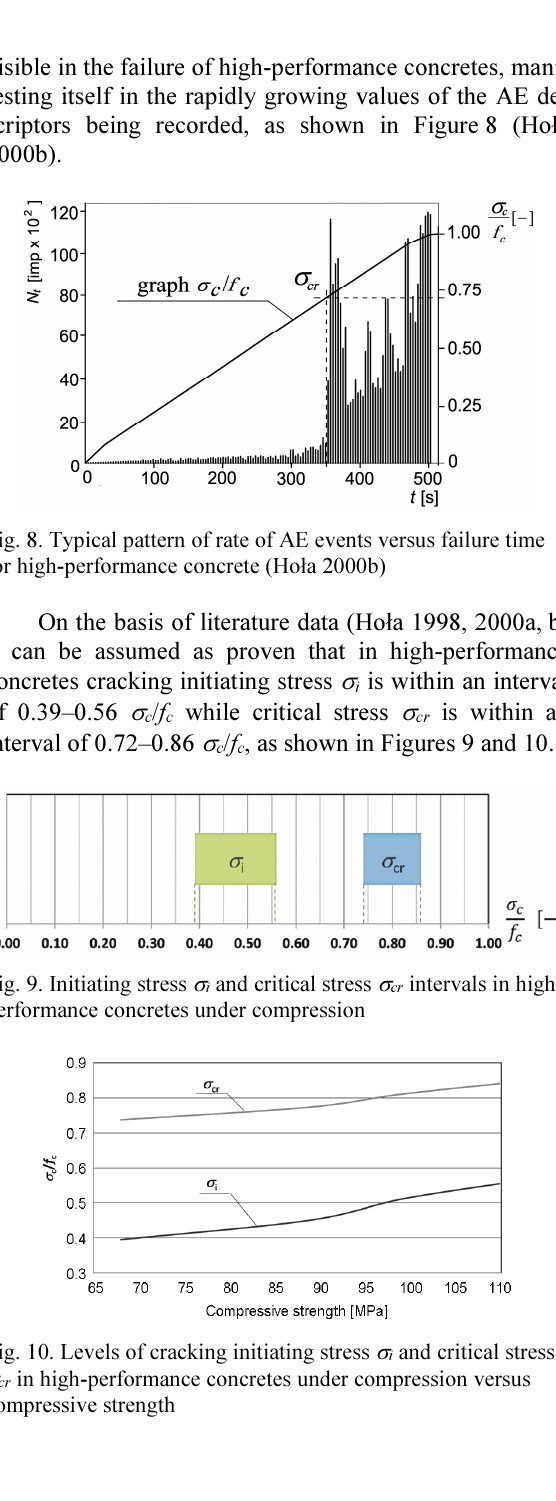
Fig. 6. Rate of AE events ( N ev ) versus failure time in self-compacting concrete: a) concrete stored in climatic chamber; b) dry con- crete; c) concrete fully saturated with water